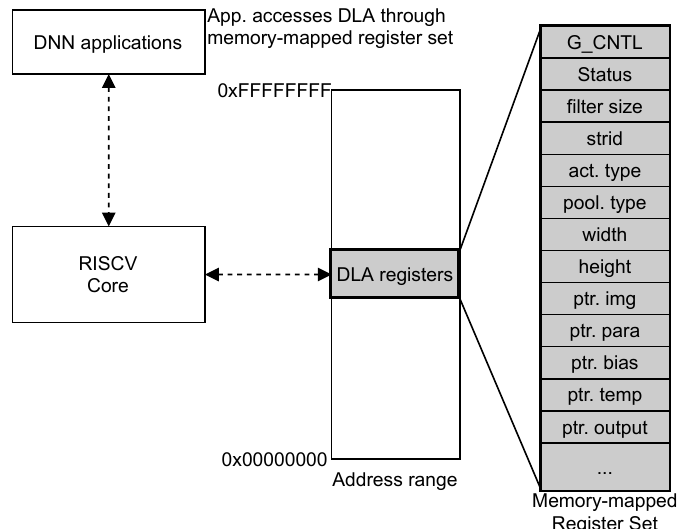
Figure 3. The memory-mapped DLA Registers and its access from software application in RISC-V VP